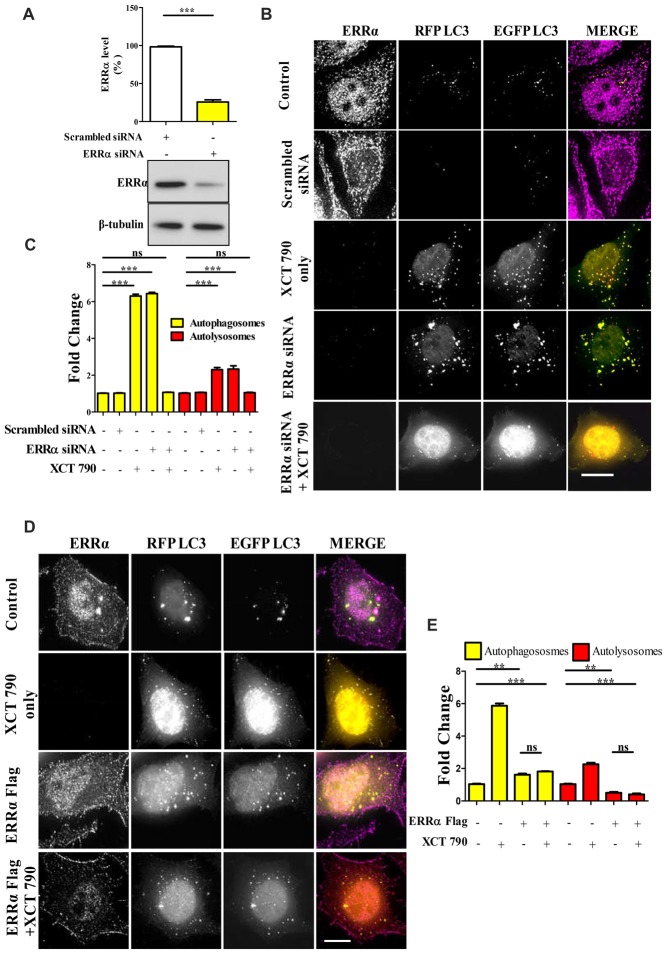
XCT 790 modulates autophagy through estrogen related receptor α (ERRα). (A) ERRα protein levels after transfecting either scrambled siRNA (100 picomoles) or ERRα siRNA (100 picomoles) for 48 h in HeLa cells was analyzed by Western blotting and then quantified (n = 3). β-tubulin was used as a loading control. Statistical analysis was performed using two-tailed paired t-test. Error bars, mean ± SEM. ***P < 0.001. (B,C) Microscopy images (B) of tandem RFP-EGFP-LC3 assay in XCT 790 treated HeLa cells (2 h) post ERRα siRNA transfection (48 h). Cells were immunostained for ERRα in various treatments. Scale bar was 15 μm. Quantification (C) of autophagosomes (yellow puncta) and autolysosomes (red puncta) modulated by XCT 790 treatment in ERRα siRNA transfected cells (n = 50 cells and three independent experiments). Statistical analysis was performed using one-way ANOVA and the post hoc Bonferroni test. Error bars, mean ± SEM. ns-non significant, ***P < 0.001. (D,E) Microscopy images (D) of tandem RFP-EGFP-LC3 assay in XCT 790 treated HeLa cells (2 h) post ERRα Flag transfection (48 h). Cells were immunostained for ERRα in all treatment groups. Scale bar used was 15 μm. Quantification (E) of autophagosomes (yellow puncta) and autolysosomes (red puncta) modulated by XCT 790 treatment in ERRα Flag transfected cells (n = 50 cells and three independent experiments). Statistical analysis was performed using one-way ANOVA and the post hoc Bonferroni test. Error bars, mean ± SEM. ns-non significant, **P < 0.01, ***P < 0.001. Concentration of XCT 790 used was 5 μM.